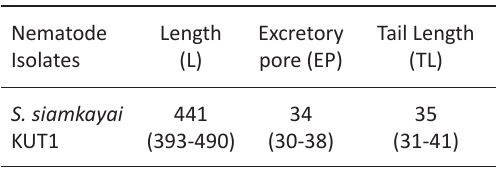
Table 2. Morphometric characters of infective juveniles of S.siamkayai (n=25) (Mean and Range, all measurements in μm)